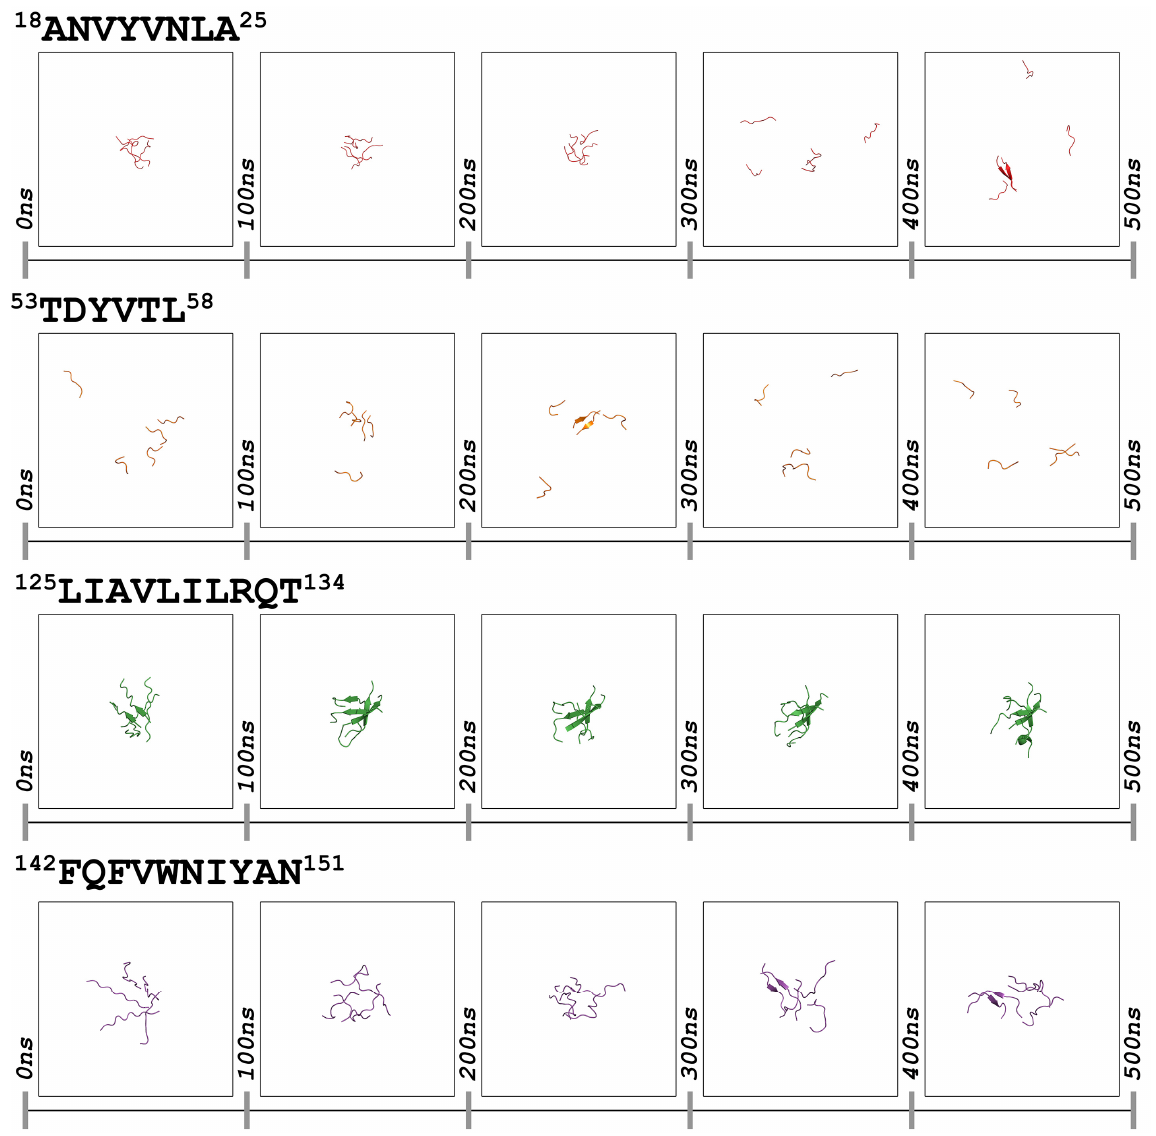
Figure 3. MD simulations of 18 ANVYVNLA 25 , 53 TDYVTL 58 , 125 LIAVLILRQT 134 , and 142 FQFVWNIYAN 151 peptide-analogues. In every case, a solvent box containing five copies of each peptide-analogue was simulated for 500 ns. Peptide-analogues are shown as cartoons, utilizing PyMOL v.2.5.0 [32].